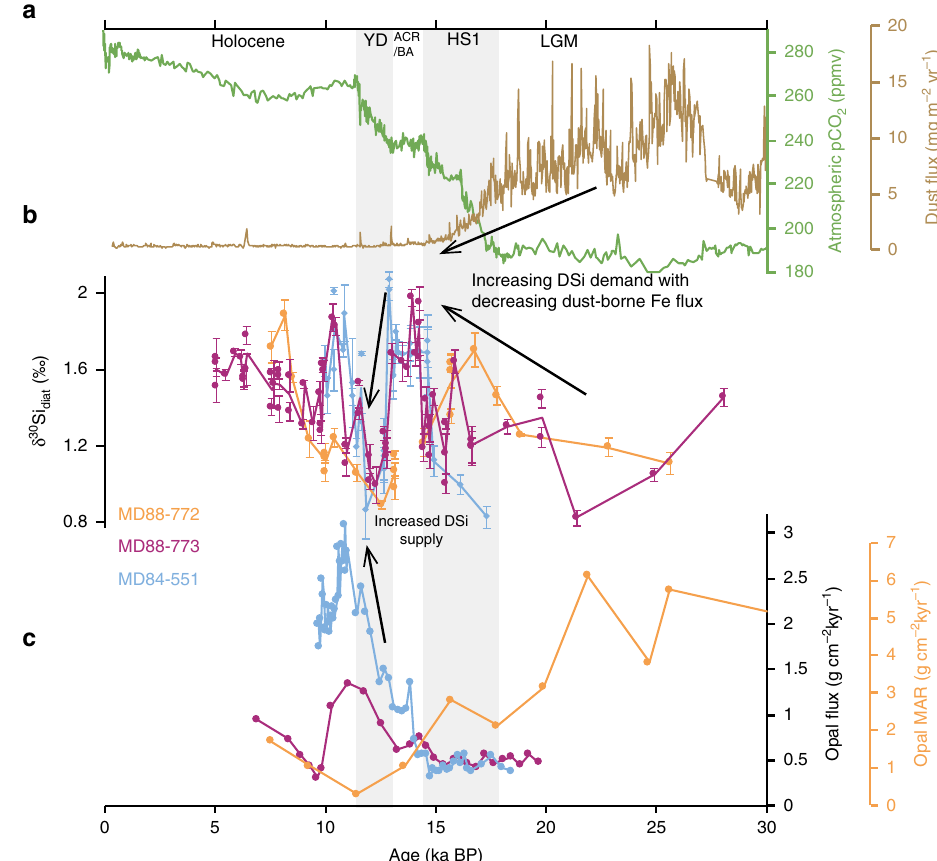
Fig. 2 Deglacial δ 30 Si diat and opal records from the three Indian sector cores. a Atmospheric CO 2 1 and Antarctic dust fl ux 40 recorded in EPICA Dome C. b δ 30 Si diat data from MD84-551, MD88-773 and MD88-772 with ± 1SE. c 230 Th-normalised opal fl ux records from MD84-551 and MD88-773 ( 230 Th- normalisation data from Francois et al. 80 ,) and opal mass accumulation rate (MAR) from